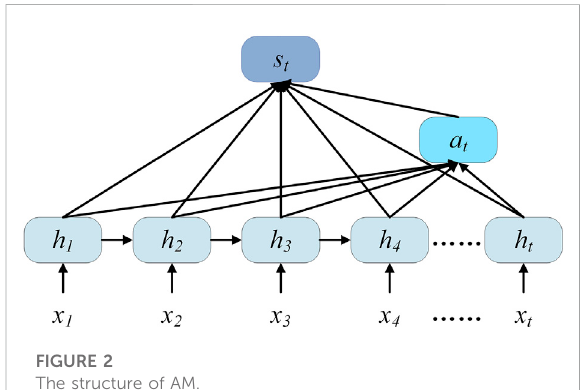
FIGURE 2 The structure of AM.